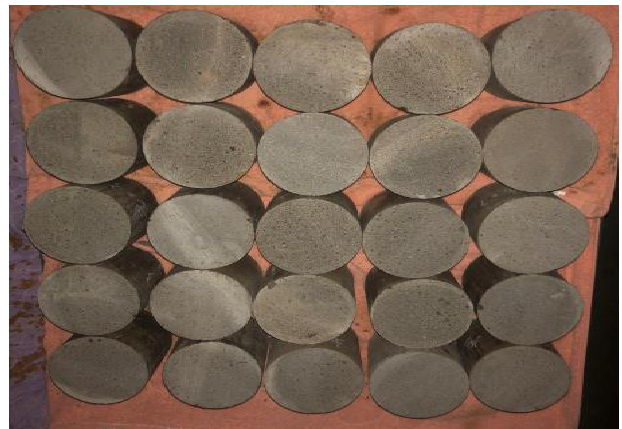
Figure 1. Polished CA mortar specimens.